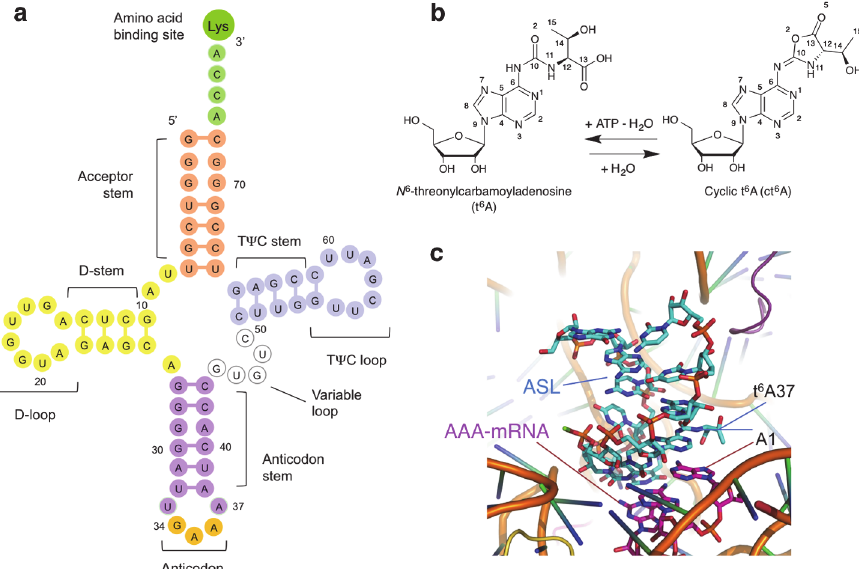
Fig 1. Cyclic N 6 -threonylcarbamoyladenosine (cyclic t 6 A, ct 6 A) hypermodification in tRNA. a Schematic cloverleaf representation of tRNA Lys UUU showing the location of the ct 6 A modification at A37. b TcdA catalyzes the ATP-dependent cyclization of t 6 A into ct 6 A in tRNAs with ANN anticodons in bacteria, yeasts, fungi and plants, which occurs mainly at the A37 position of the anticodon stem loop (ASL) of the tRNA molecule. ( c ) Recognition of the AAA codon on mRNA by ASL of tRNA Lys UUU involves interactions between t 6 A37 and A1 from the AAA codon (PDB